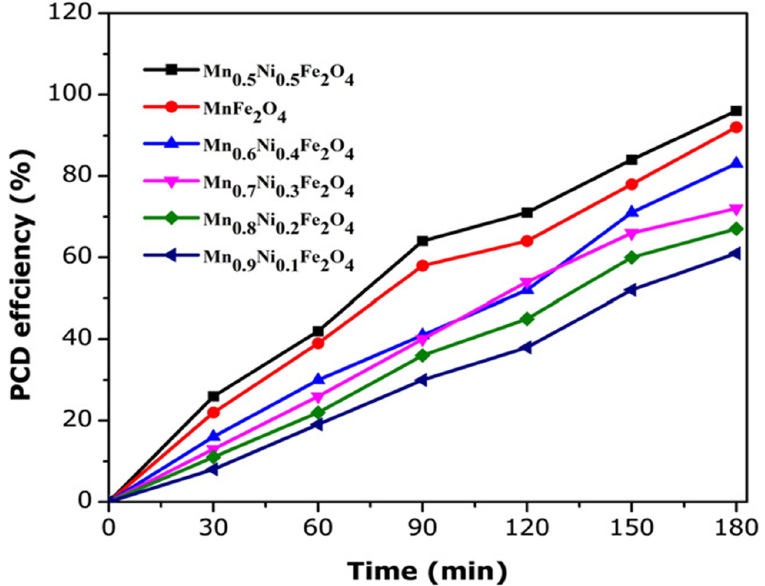
Figure 14. Effect of Ni 2+ ions doped MnFe 2 O 4 magnetic nanoparticles on the photocatalytic degradation (PCD) efficiency. The conditions used were IC = 150 mg/L, photocatalyst = 50 mg/100 mL, and λ = 365 nm) [118]. Republished with permission from Elsevier.